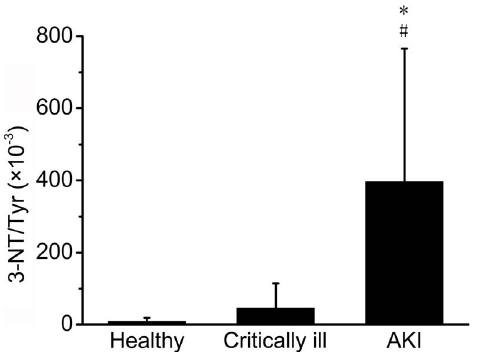
Figure 1. 3-NT/Tyr among healthy subjects, critically ill patients without AKI and patients with AKI. * t test p , 0.001, AKI patients compared to criticall ill patients; # t test p , 0.001, AKI patients compared to healthy subjects.